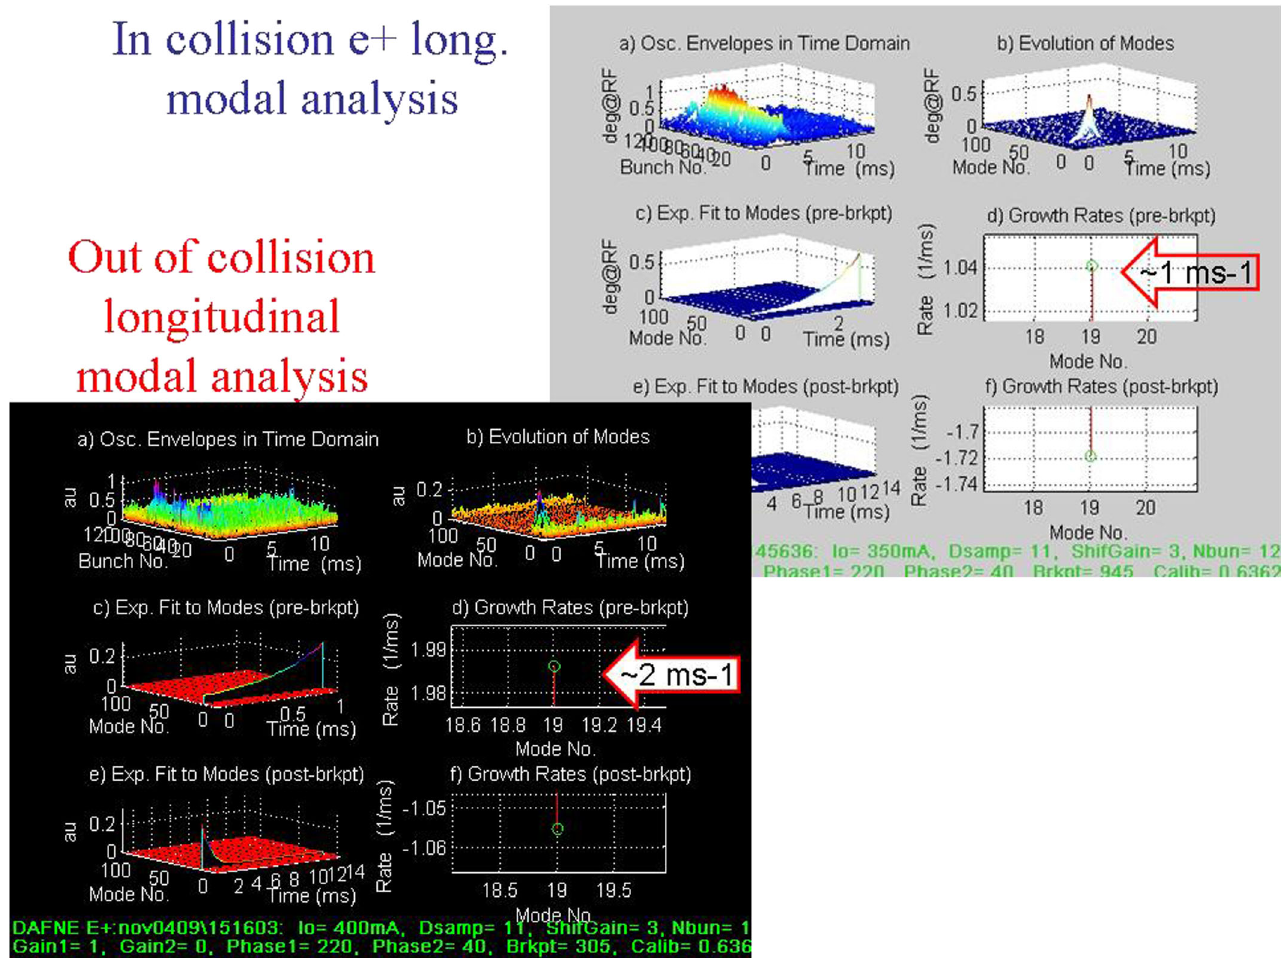
FIG. 5. The growth rate of mode 19 out of collision is 1 : 99 ms (cid:1) 1 , in collision 1 : 04 ms (cid:1) 1 .